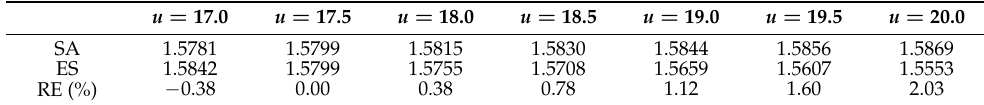
Table 2. The values of V ( u ;50 ) when λ = 1, µ = 1, δ = 0.06, c = 0.4, α = 0.1. u =